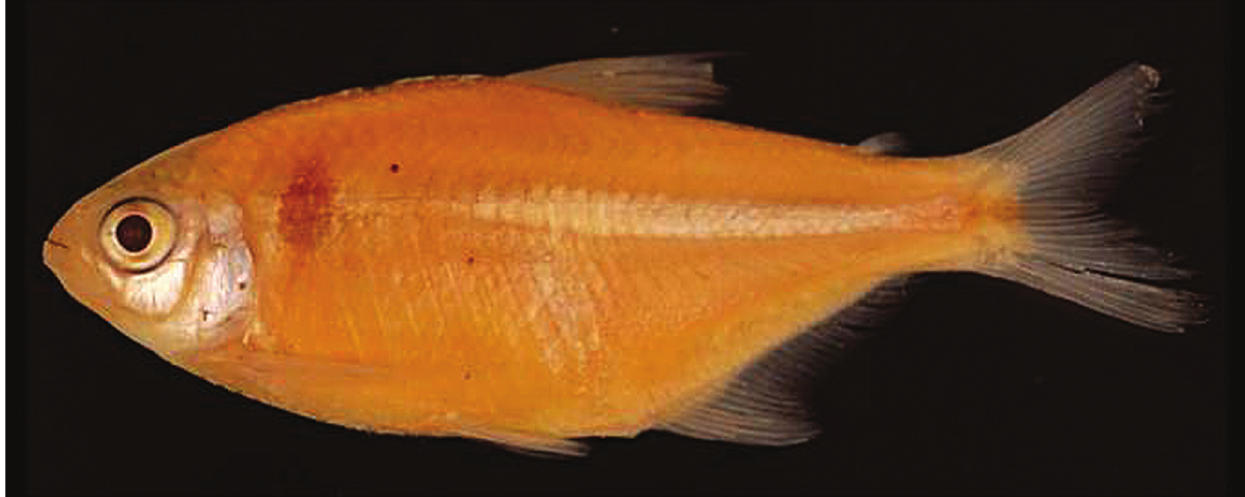
Fig. 7. Probolodus sazimai , holotype, MCP 47870, 56.7 mm SL, Brazil, Minas Gerais, município de Ipatinga, rio Taquaruçu, rio Doce